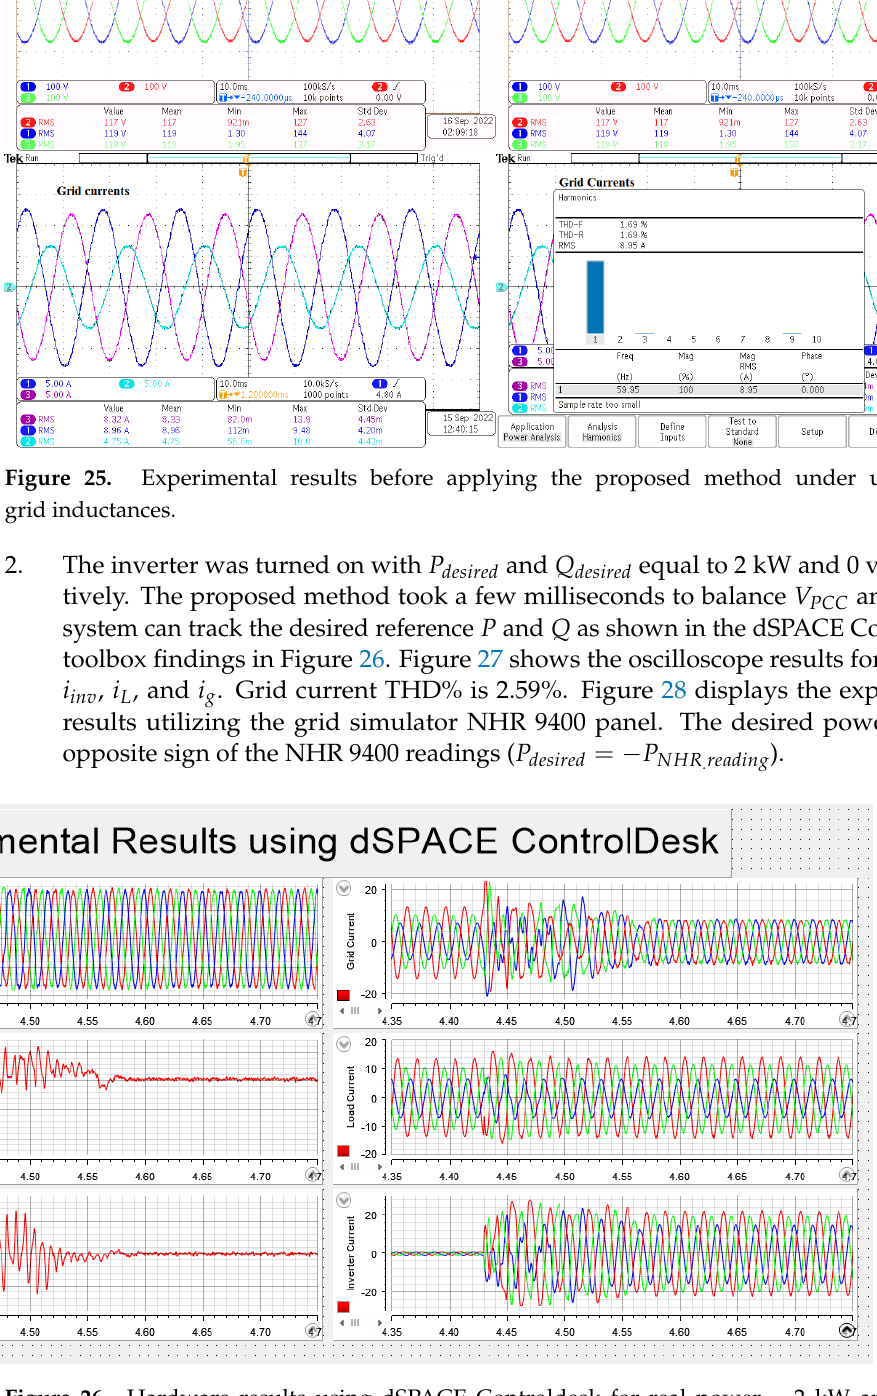
Figure 26. Hardware results using dSPACE Controldesk for real power = 2 kW and reactive power = 0 var under unbalanced grid